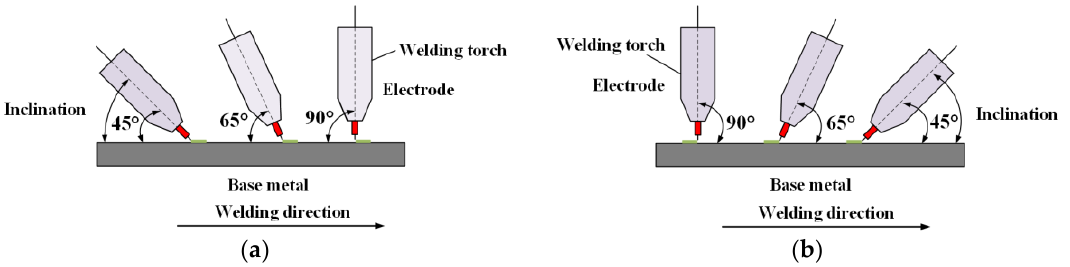
Figure 2. The presentation of two inclination modes. ( a ) Forward inclination angle, ( b ) backward inclination angle.